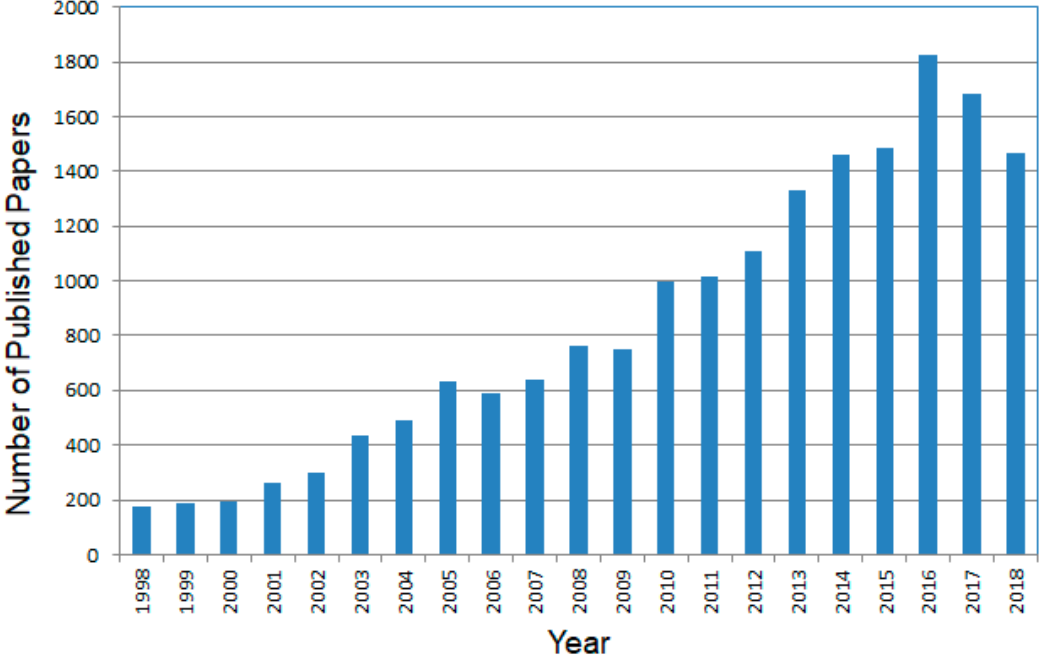
Figure 1. Evolution of number of publications concerning the masonry materials and structures based on Scopus bibliographic database (28 December 2018).